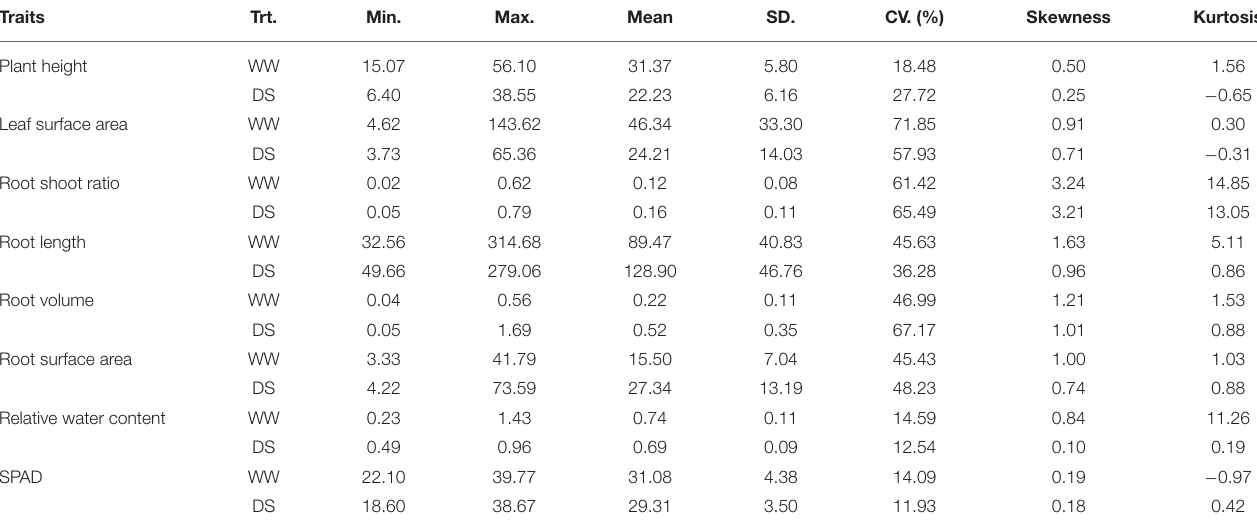
TABLE 1 | Descriptive statistics values for traits of 226 sunflowers under drought stress. Traits Trt. Min. Max. Mean SD. CV. (%) Skewness Kurtosis